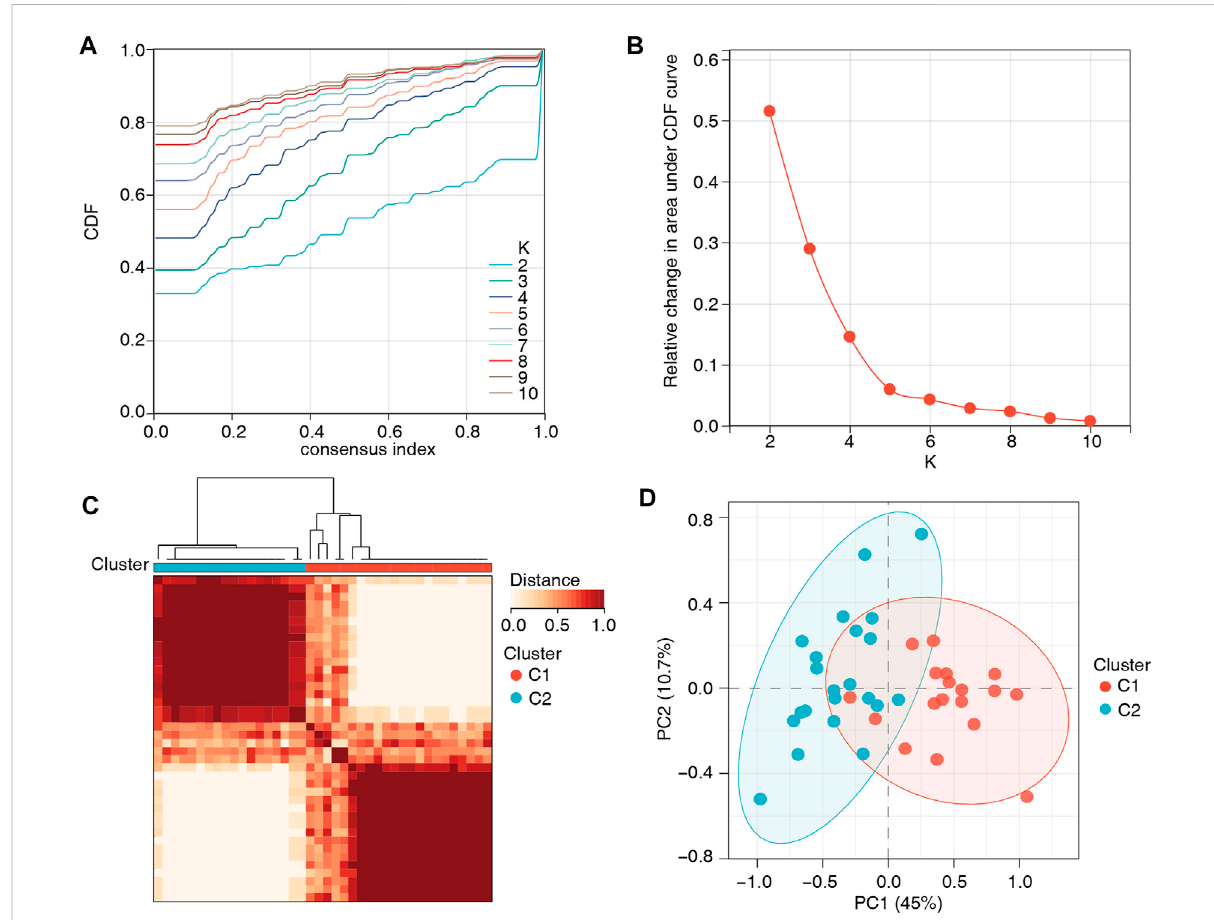
Unsupervised clustering analysis based on the 14 m6A regulators. (A,B) Consensus clustering cumulative distribution function (CDF) and the relativeareaundertheCDFcurvefor k=2 – 10.Accordingto therecommendationsfor selectingthenumberofclusters, thenumberofclusterswith thehighestaverageconsistencywask=2. (C) Theheatmapshowstheconsensusmatrixfortheoptimalk=2. (D) ThePCAplotcon fi rmedthestriking difference between the two m6A modi fi cation